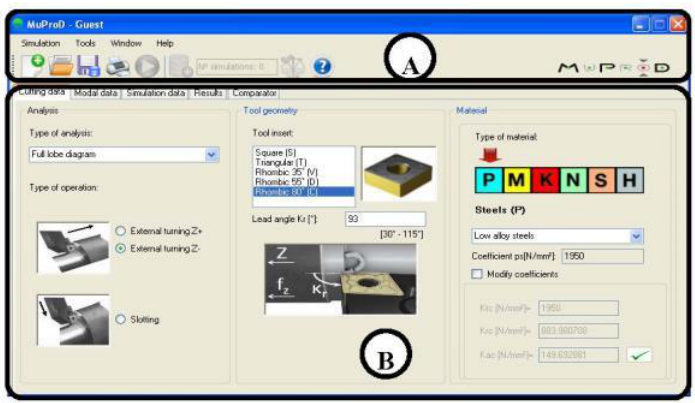
Figure 1. Example of the main machining interface window.